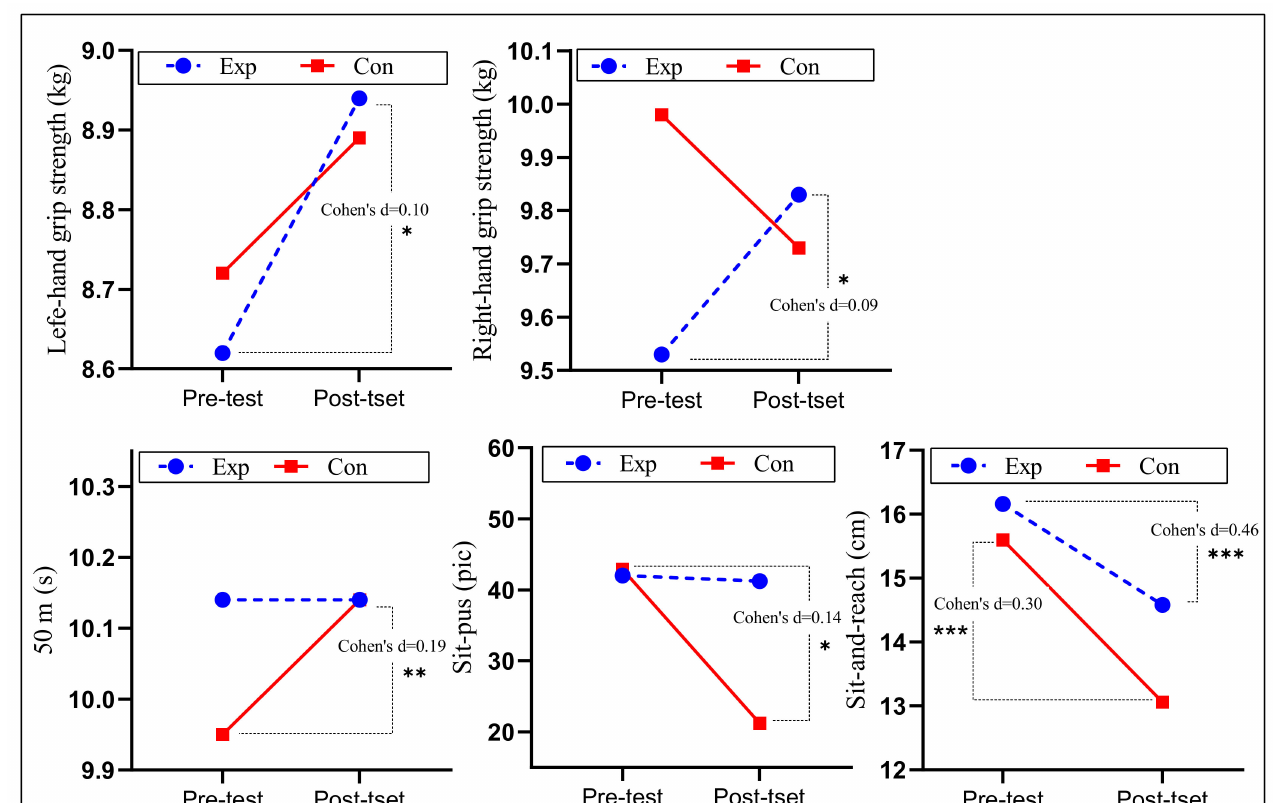
Figure 5. Descriptive statistics and within-group variations in the means of physical fitness. *: p < 0.05;